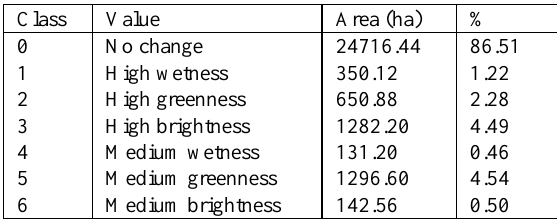
Table 3. Landscape dynamic classes and their corresponding area in the